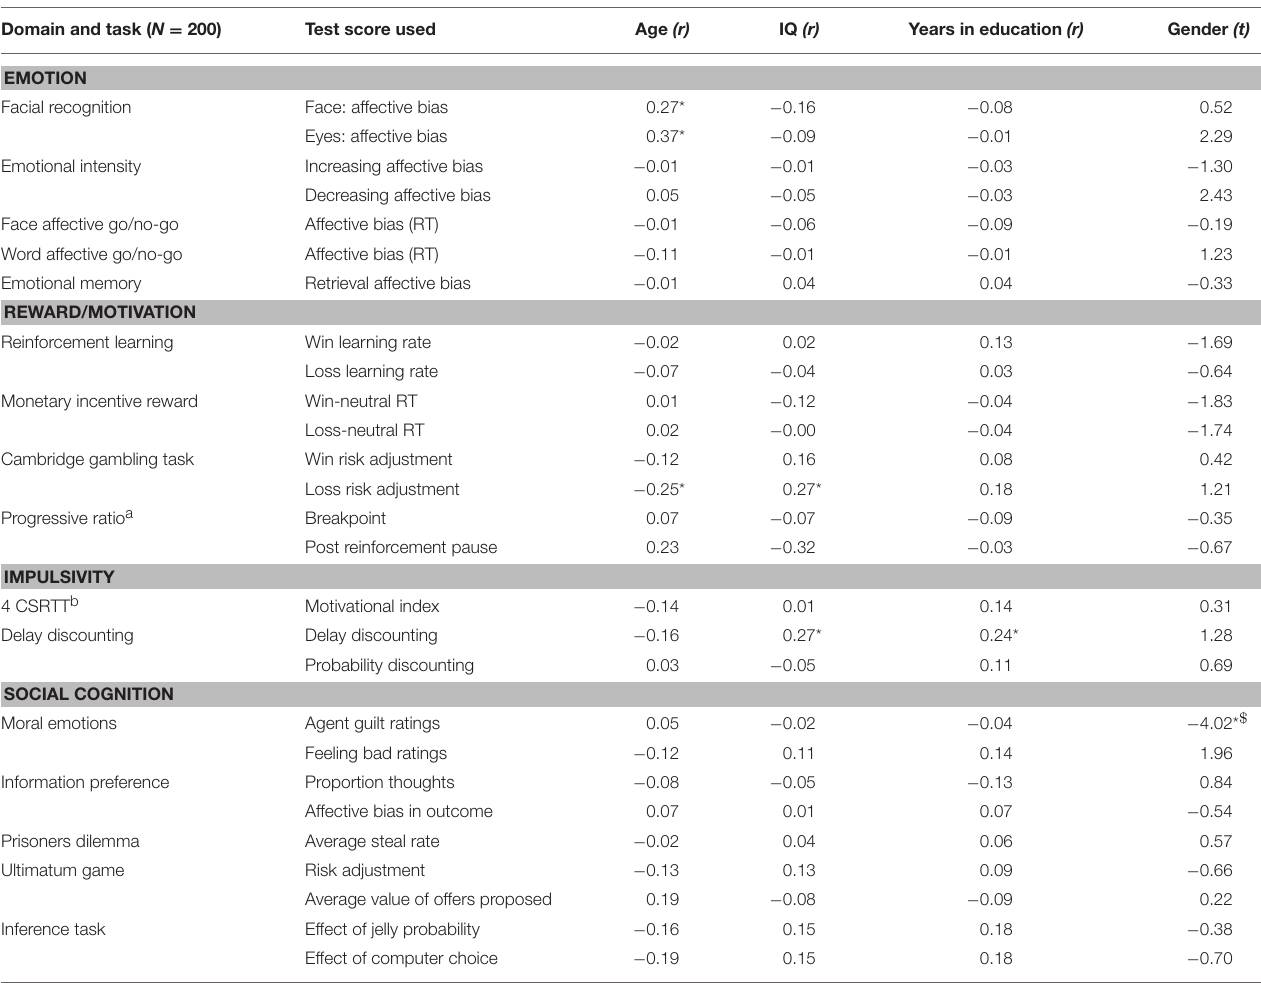
TABLE 6 | Association between tasks and demographic characteristics. Domain and task ( N =